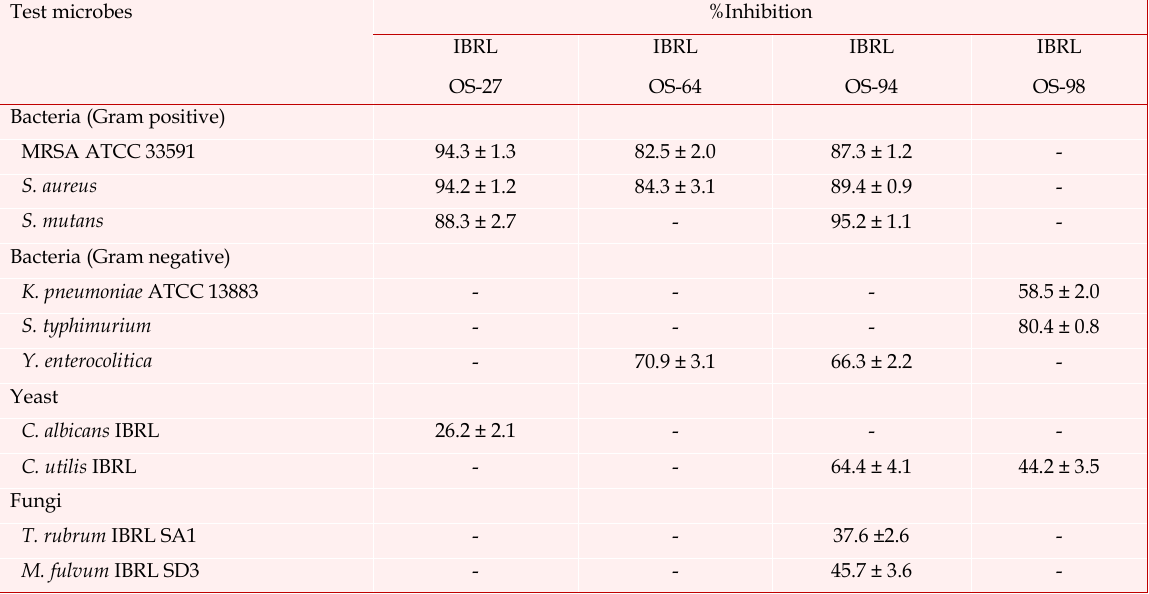
Antimicrobial activity of volatile compounds produced by endophytic fungi against pathogenic microorganisms Test